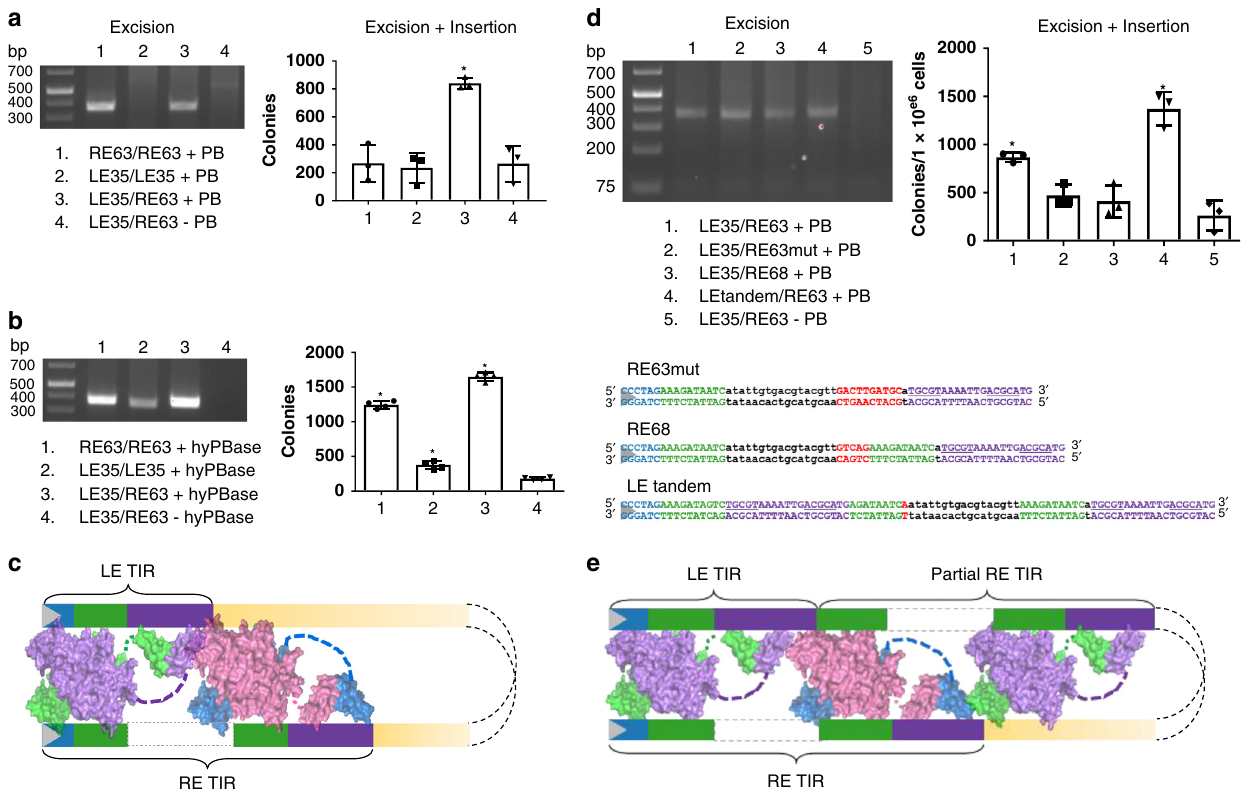
Fig. 6 Proposed transpososome with LE/RE TIR bound and in vivo transposition assays. a Excision (left) and colony count transposition analysis (right) in cultured HT-1080 cells using wild type PB. Excision was assayed by PCR detection of repaired excision sites. Excision and subsequent integration are assessed by colony count, which represents events in which the resistance gene (located between pB TIRs) is integrated into the chromosome by pB transposition. The resulting cells form colonies in the presence of G418, indicating the full transposition pathway from excision to integration. Excision results are representative of three independent experiments. Colony counts, n = 3 independent experiments ± SD. b Excision (left) and Excision + integration (colony count) transposition analysis (right) in cultured HT-1080 cells using hyPBase. Excision and Excision + integration (colony count) transposition analysis in cultured HT-1080 cells is as in Fig. 6a. Colony counts, n = 4 independent experiments ± SD. c Proposed model for the asymmetrical binding of LE and RE TIRs by two PB dimers. Colored boxes in TIRs are the same as in Fig. 1b. d Excision and colony count transposition analysis in cultured HT-1080 cells of LE and RE TIR variants. RE63mut has a mutated green repeat, RE68 has fi ve additional bp inserted as indicated in red, and LEtandem is lengthened by repeating a region of the RE TIR as shown in e . Excision assays shown are representative of three independent experiments. Colony counts, n = 3 independent experiments ± SD. e Proposed model representing assembly of PB with LEtandem and RE TIRs in a transpososome. The LEtandem TIR combines sequences of the LE TIR and RE TIR. The synaptic model includes three dimers of PB. Colored boxes in TIRs are the same as in Fig. 1b. Statistical analysis statement of a , b , and d : Data were analyzed using one-way ANOVA followed by Dunnett ’ s multiple comparison post-test comparing each column to the LE35/RE63 without control. All error bars show the standard deviation. Statistically signi fi cant differences were considered as follows: p ≥ 0.05 (ns) and p < 0.05 (*). Source data are provided as a Source Data